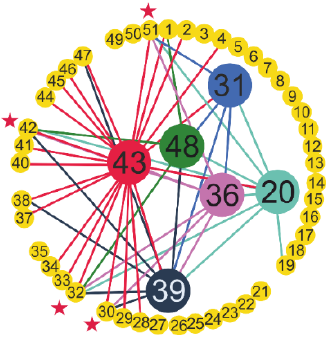
Figure 6. Pairs of features with high classification efficiency SARS-CoV-2-RBV1 dataset for the Histogram-based Gradient Boosting classifier.